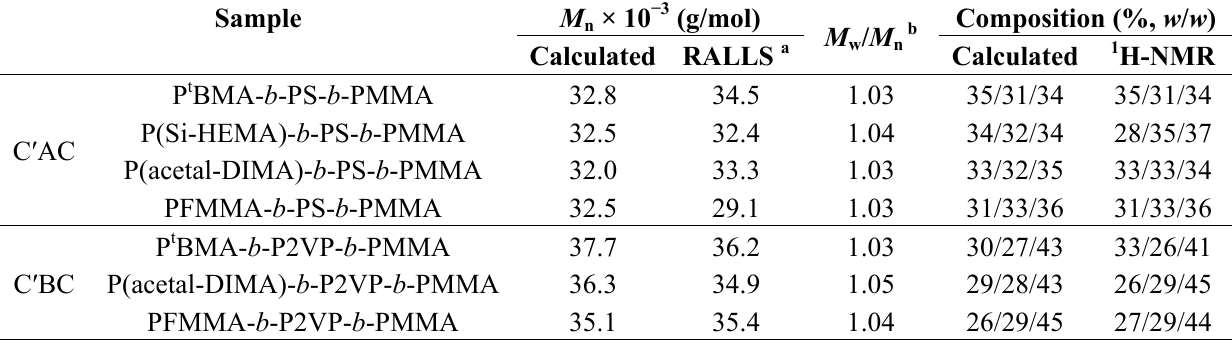
Table 7. Molecular characteristics of C ′ AC and C ′ BC triblock